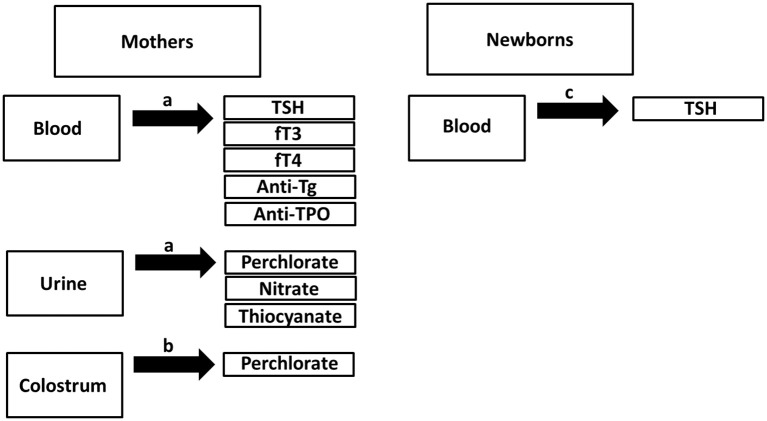
Overview of sample collection. aSample collection in the first 48 post-partum hours. bSample collection either in the first 72 postpartum hours for subjects having C-section or 48 postpartum hours for subjects having vaginal delivery. cSpot blood collection using heel prick test >48th postpartum hours.